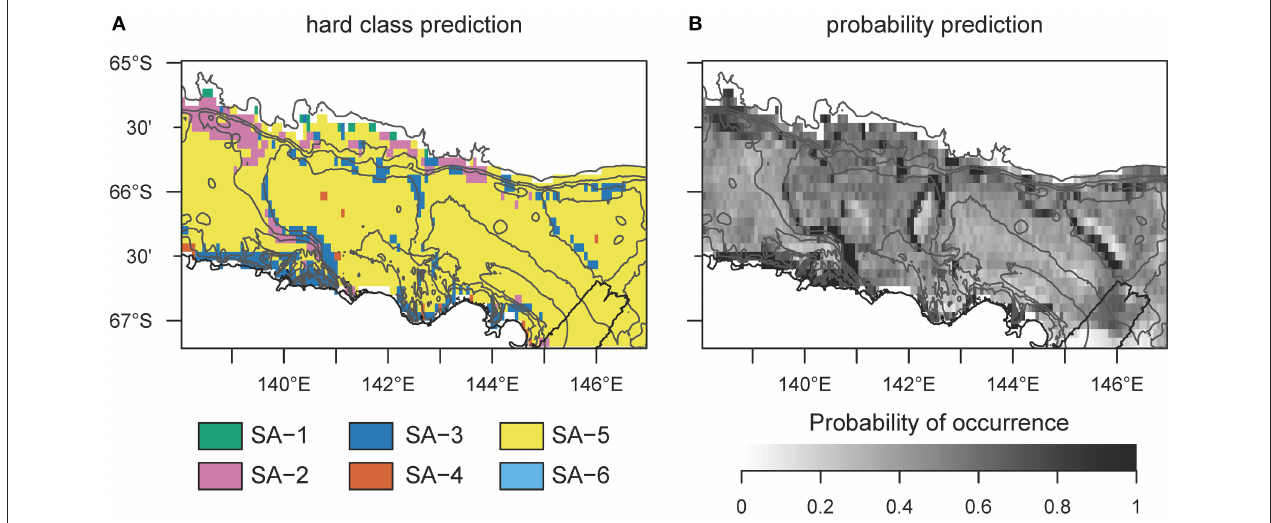
FIGURE 4 | Hard classed distribution of six archetype predictions across the George V shelf, East Antarctica. Map (A) identifies which group of species is most likely to be encountered at any specific prediction point across the study area. (B) shows the probability of occurrence for the most likely archetype. These maps do not provide any indication of similarity or difference between sites for which a different analysis, such as regions of common profile ( Foster et al., 2013), is needed. SA − 6 never dominates the